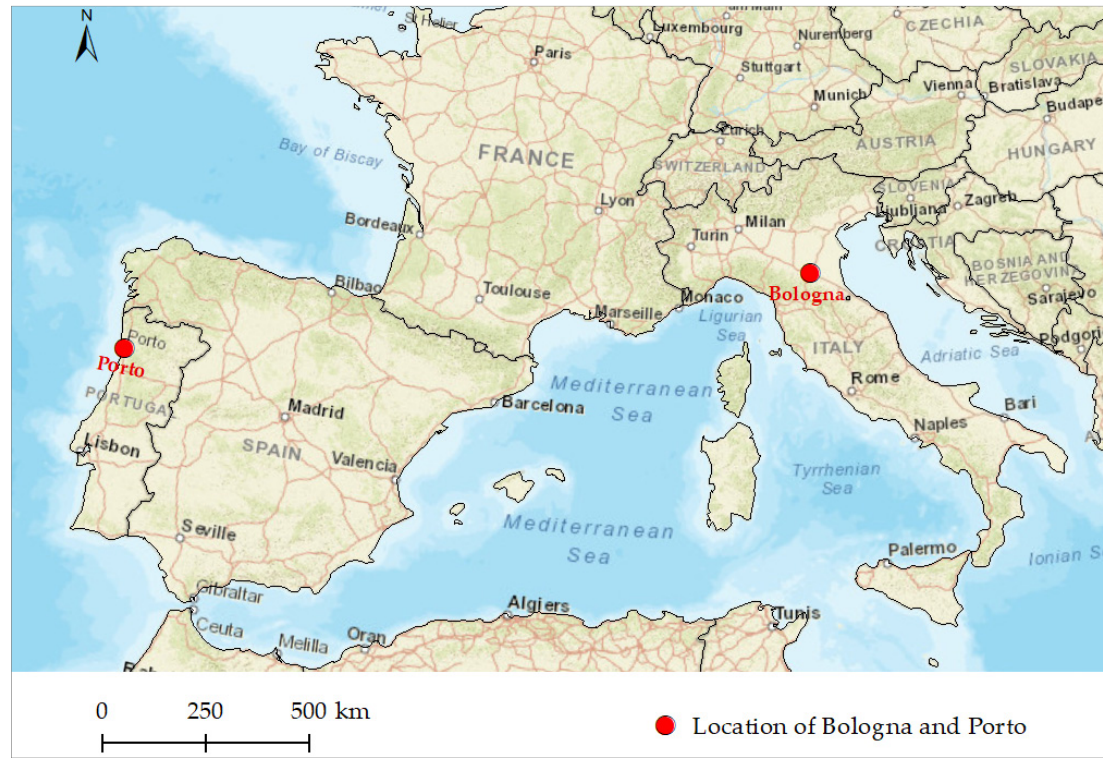
Figure 1. Location of Bologna and Porto in Italy and Portugal, respectively. Source: ArcGIS World Street Map.